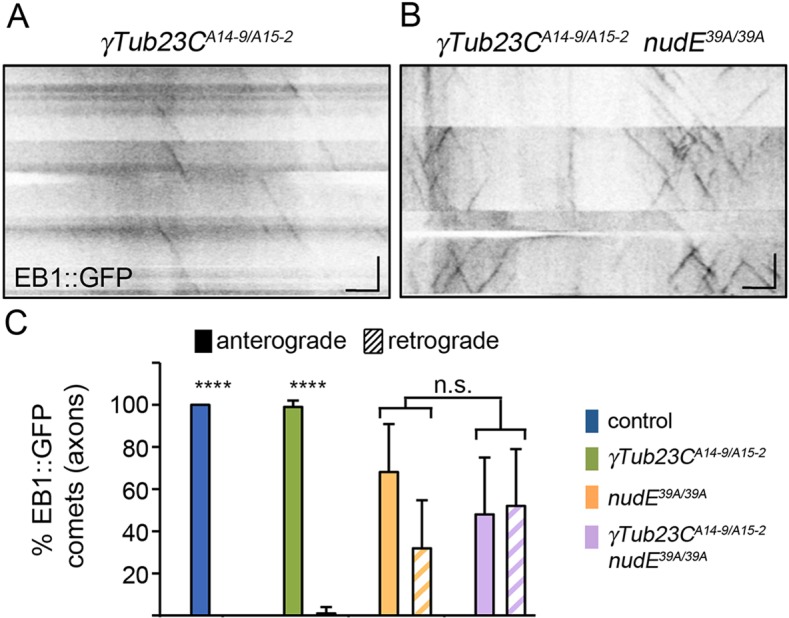
γ-tubulin-mediated microtubule nucleation is not responsible for the change in axonal microtubule polarity
that is
caused by the loss of NudE. (A,B) The polarity of axonal microtubules was determined using EB1–GFP, the comet trajectories of which are plotted in kymographs. The cell body is to the left in all kymographs. Scale bars: 5 µm (x axis); 30 s (y axis). (C) Quantification of the direction that EB1–GFP comets traveled in axons. γTub23CA14-9/A15-2, n=16 axons with 156 comets. γTub23CA15-2/A14-9; nudE39A/39A, n=12 axons with 193 comets. The percentage of comets traveling anterograde and retrograde in the axons of nudE39A/39A and γTub23CA15-2/A14-9; nudE39A/39A neurons was significantly different from control (****P<0.0001 for both genotypes). n.s., not significant.